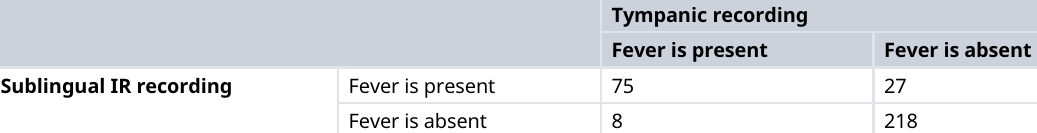
Table 2. Contingency table for evaluating diagnostic accuracy of sublingual infrared recordings.